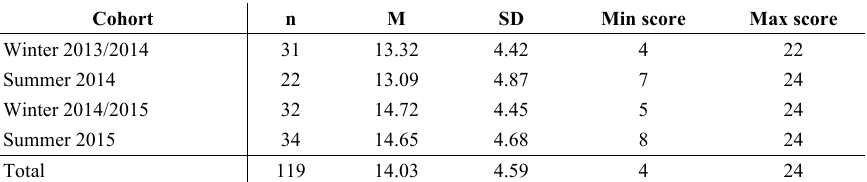
Table 1. Mathematics placement test scores by